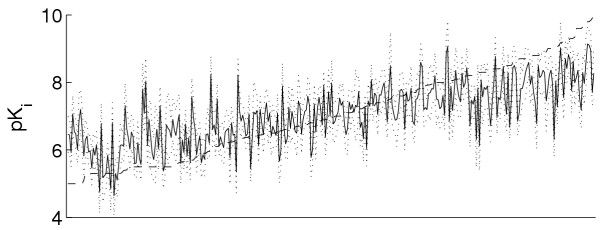
External predictions for amine data set. External predictions for amine data set sorted according to growing values of pKi. The figure shows the experimental pKi values (dashed line) and the mean value of the predicted pKi values (solid line) with a 95 % confidence interval (dotted lines). The predictions shown in the figure are from the PLS modelling after variable selection using PLSfilter. The results indicate that the high and low pKi values are hard to predict.